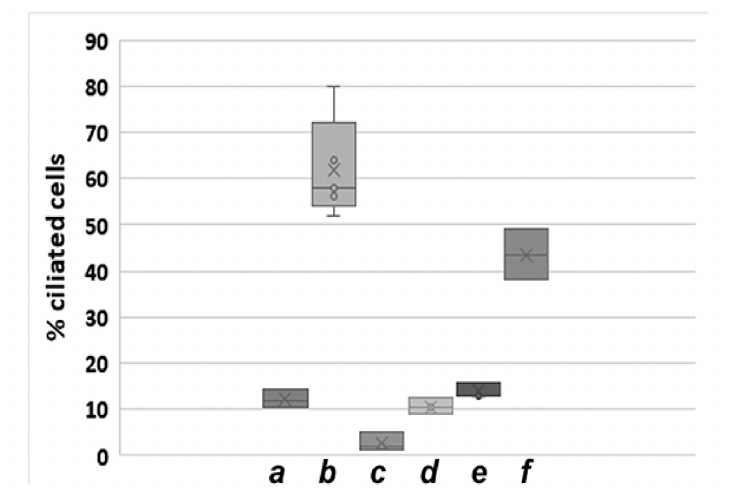
Figure 9. Arl13b is a reliable marker for primary cilia. Induction of ciliation by serum deprivation in NIH3T3 “DSMZ” as well as NIH3T3 F-con cells. NIH3T3 sub-cell line F-con (a–d) and NIH3T3 “DSMZ” cells (e,f) were cultivated in standard medium (a,e), serum starvation medium (b,c,f), or standard medium with TSA (d). Using Arl13b immune staining, primary cilia increased from 12.2% in standard medium (a, n = 2297) to 62% when serum starved for 48 h (b, n = 2627) in sub-cell line F-con, whereas less than 3% primary cilia were detected by acetylated tubulin decoration in serum starved cells (c, n = 1580). Inhibition of HDAC6 by TSA did not cause an increase in Arl13b-decorated cilia in standard medium (d, ~10%, n = 1535). In the NIH3T3 “DSMZ” cell line Arl13b-decorated primary cilia increased from 14% in standard medium (e, n = 1555) to ~44% in serum starvation medium (f, n = 1035). Serum starvation of “DSMZ” cells two biological replicates, all other three biological replicates.